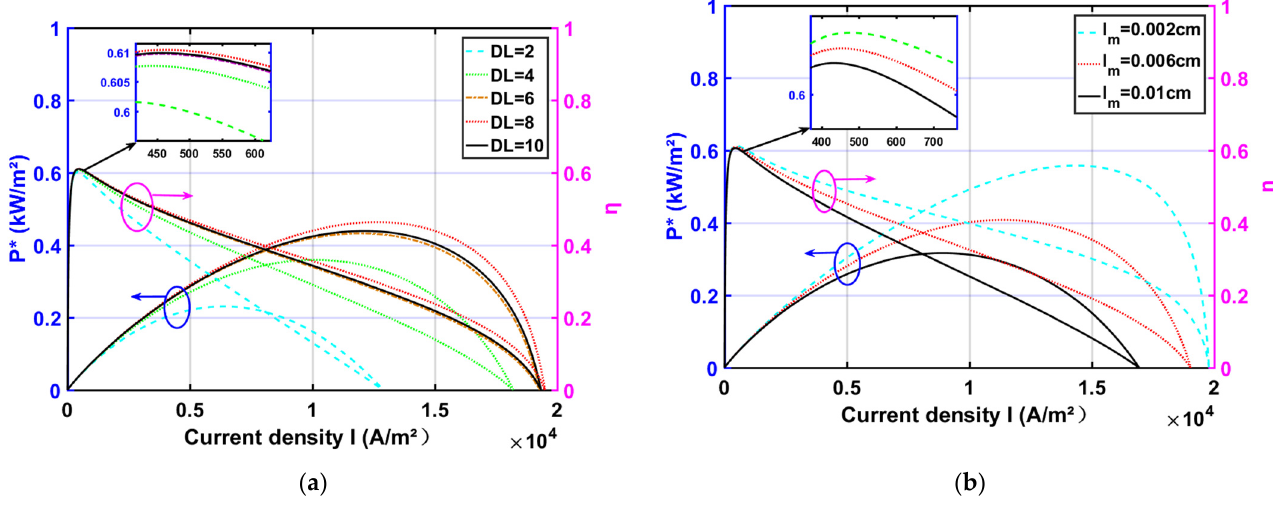
= 1 atm; (cid:1868) (cid:3016) = 1 atm; (cid:1844)(cid:1834) = = 1 atm; p = 1 atm; O 2 (cid:3118) (cid:3118) 2